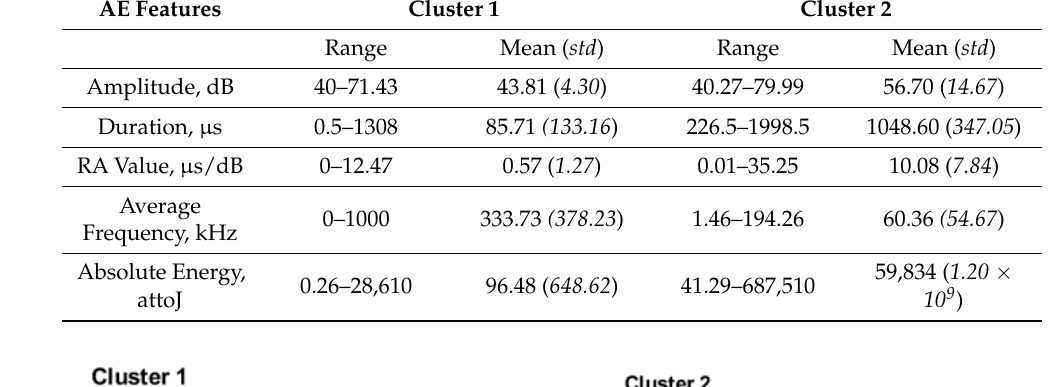
Figure 7. Clustering solutions for adhesive wear test showing ( a ) duration vs amplitude and ( b ) hits vs amplitude plots. Table 3. Range and mean (including standard deviation) of five features per cluster for adhesive wear tests.